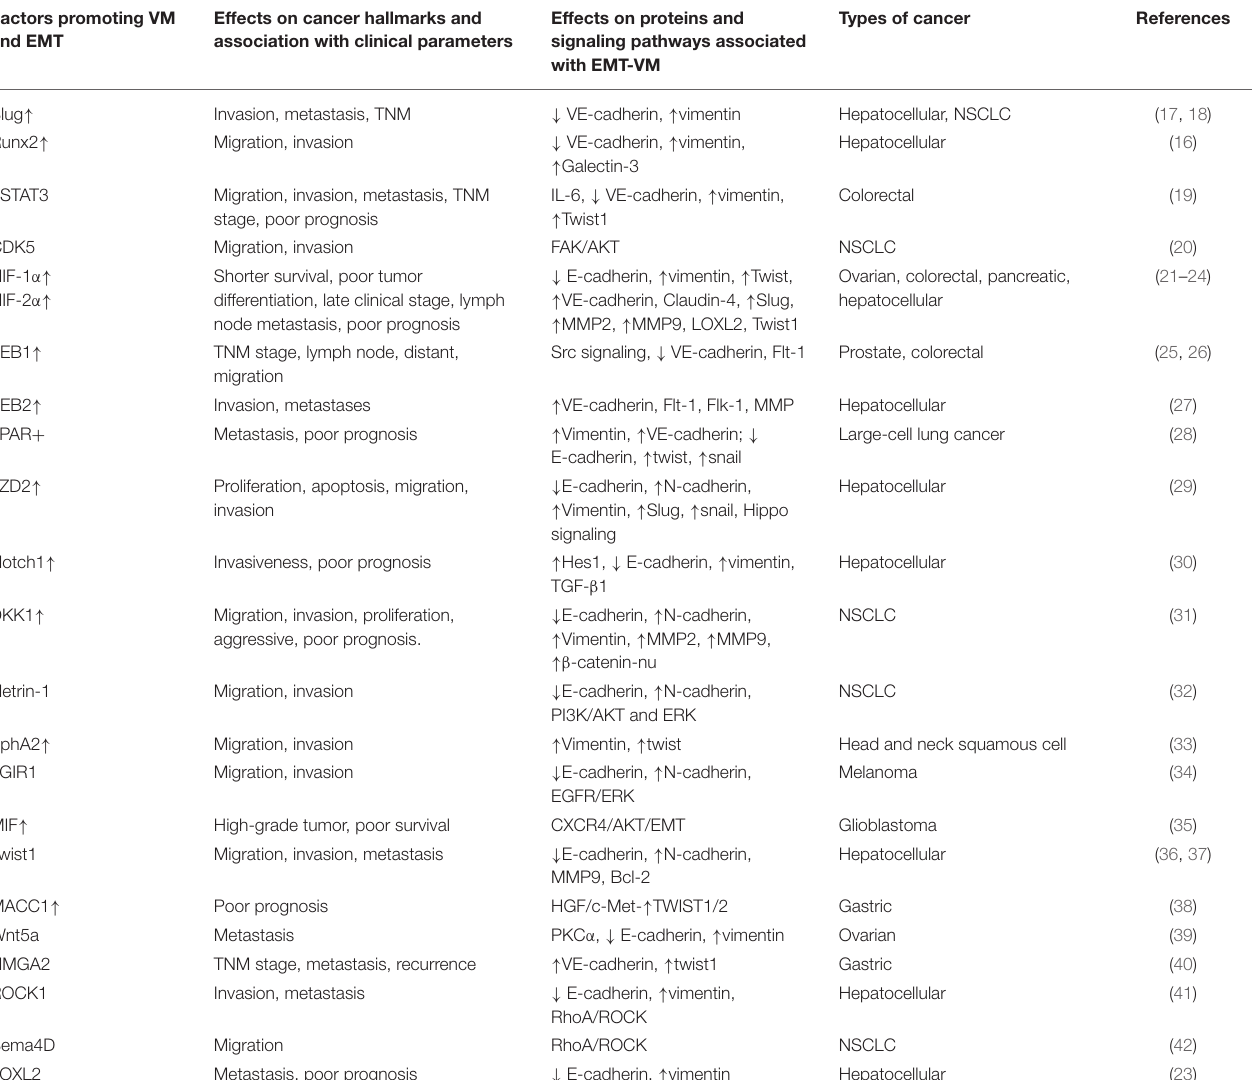
TABLE 1 | Molecular factors that promote the EMT and VM in solid tumors. Factors promoting VM and